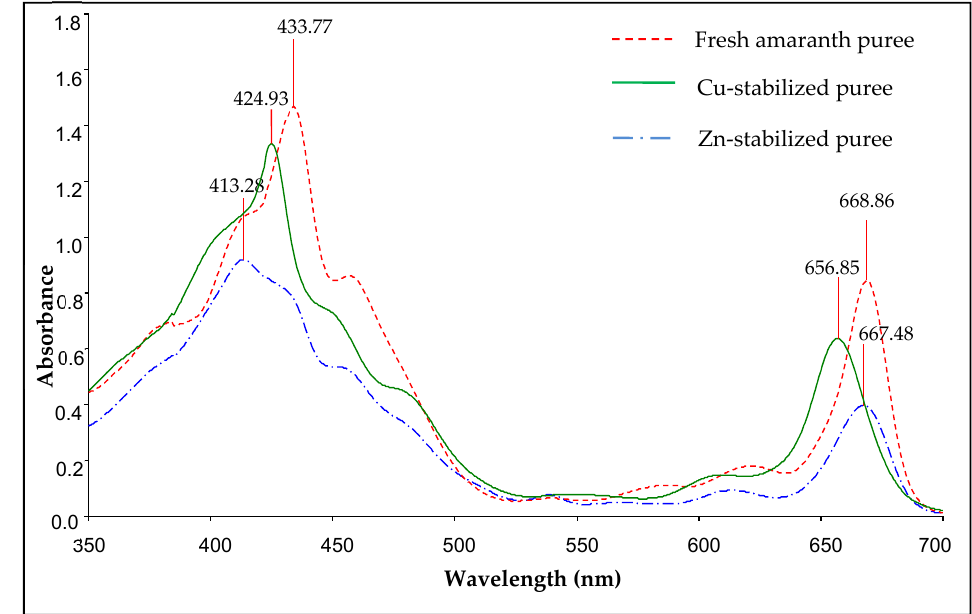
amaranth puree: 120 mg/L of CuSO 4 at 80 °C for 15 min, Zn-amaranth puree: 1500 mg/L of ZnCl 2 at 90 °C for 15 min.